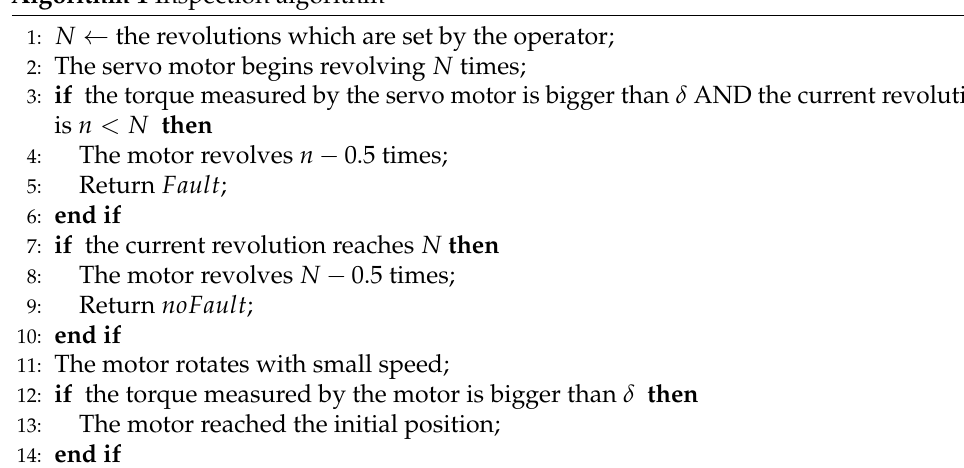
Algorithm 1 Inspection algorithm